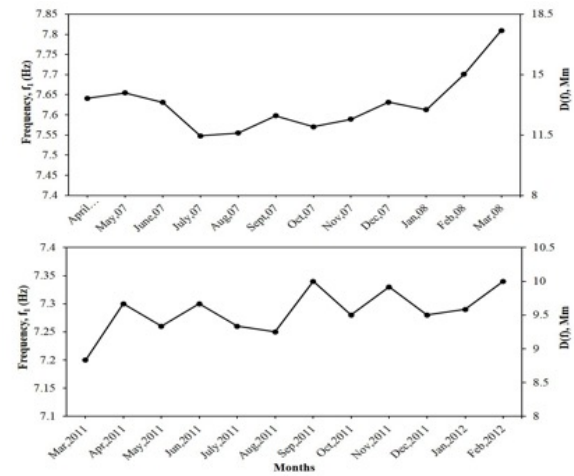
Figure 4(a). Seasonal variation of first mode SR frequency of the North-South component (X- component) of the horizontal magnetic field for period-I (upper panel) and period-II (lower panel). The ordi- nate on the right shows the corresponding source-observer distance.